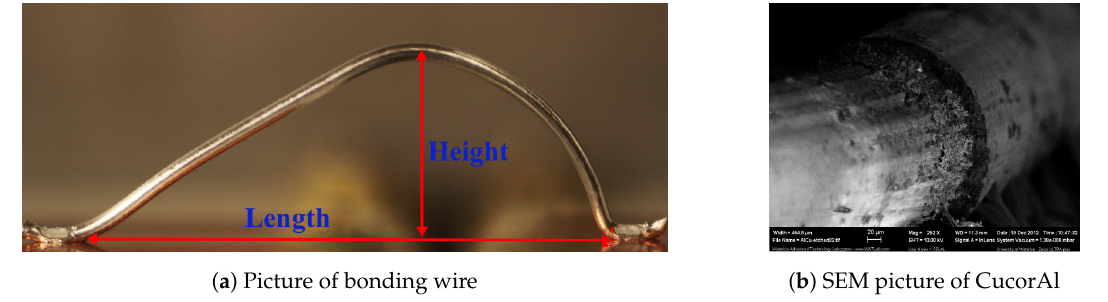
Figure 1. ( a ) Wire loop geometry and ( b ) layers of the CucorAl